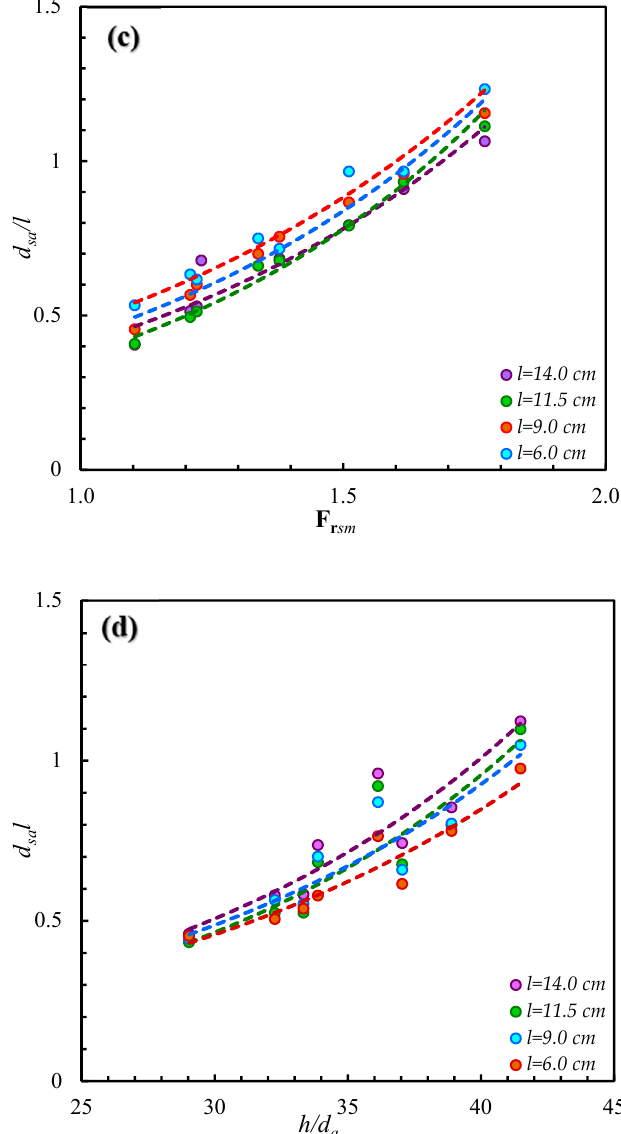
Figure 5. Influence of parameters on maximum non-dimensional scour depth. ( a ) d sa / l vs. h / l . ( b ) d sa / l vs. d a / l . ( c ) d sa / l vs. F r sm . ( d ) d sa / l vs. h / d a .